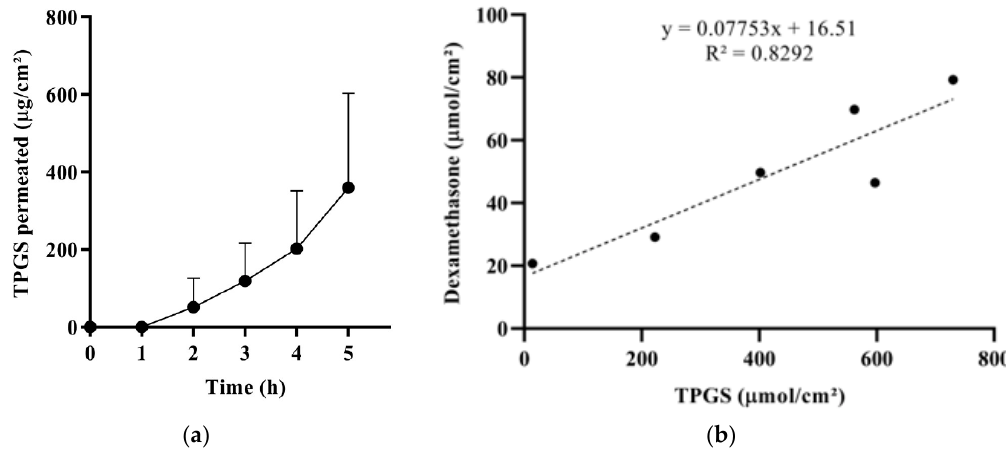
Figure 5. ( a ) Transconjunctival permeation profile of TPGS from T; the apparent permeability coe ffi